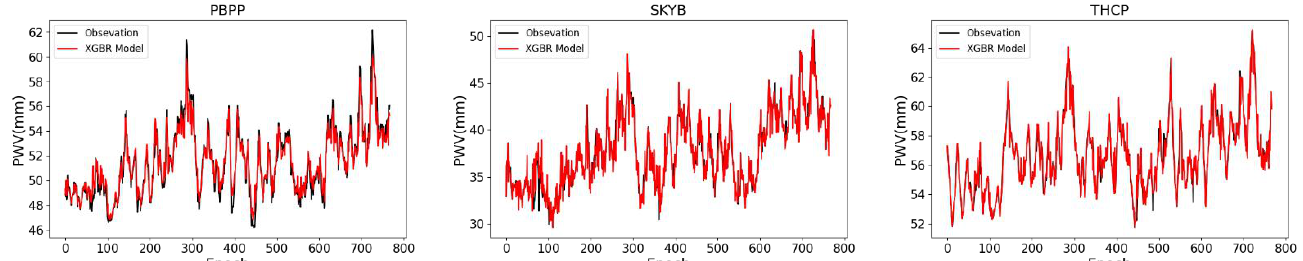
Figure 5. Time series of GNSS PWV and XGBR PWV from 27 March 2021 to 27 April 2021 at PBPP, SKYP, and THCP stations .